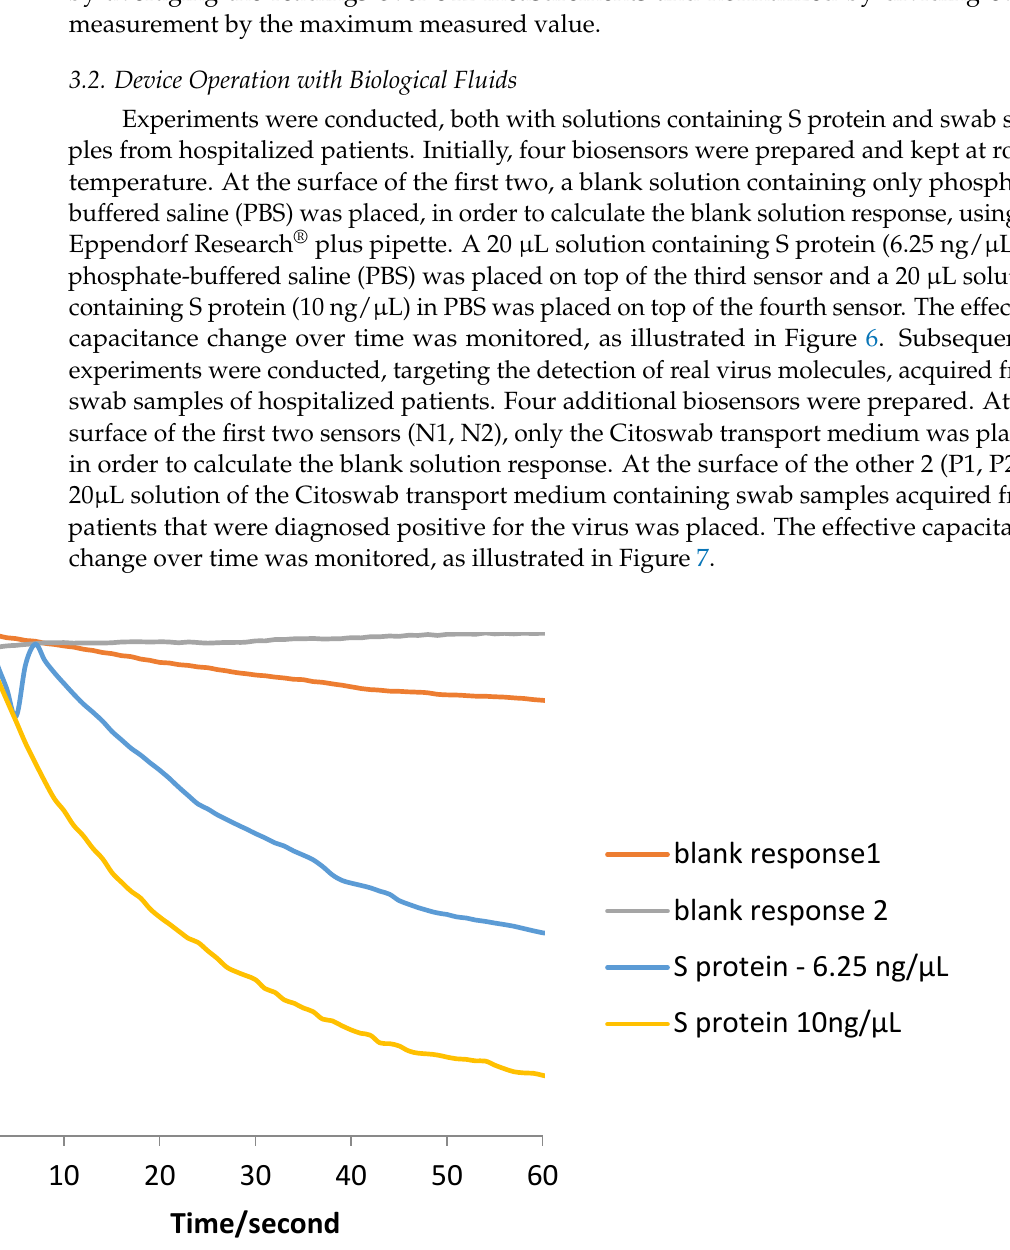
Figure 7. Normalized capacitance change over time for 4 swab samples, 2 negative to the virus (N1, N2) and 2 positive to the virus (P1, P2).